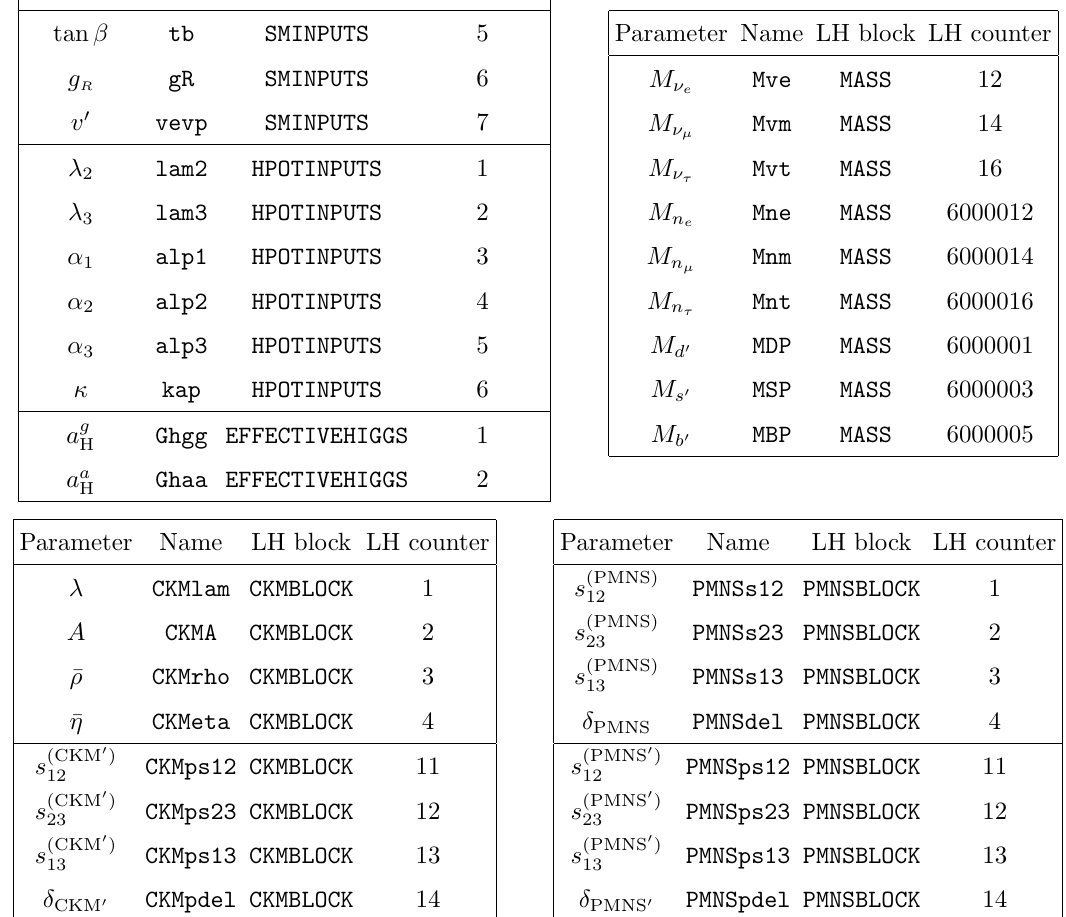
Table 8 . New physics external parameters of our ALRSM implementation, together with their name and the Les Houches (LH) block and counter information allowing to change its numerical value on run time. We recall that for consistency, (cid:20) < 0 and the conditions of eqs. (A.1) and (A.2) must be satis(cid:12)ed. Those parameters supplement the usual set of electroweak inputs given in the LEP scheme, as well as all SM fermion masses.